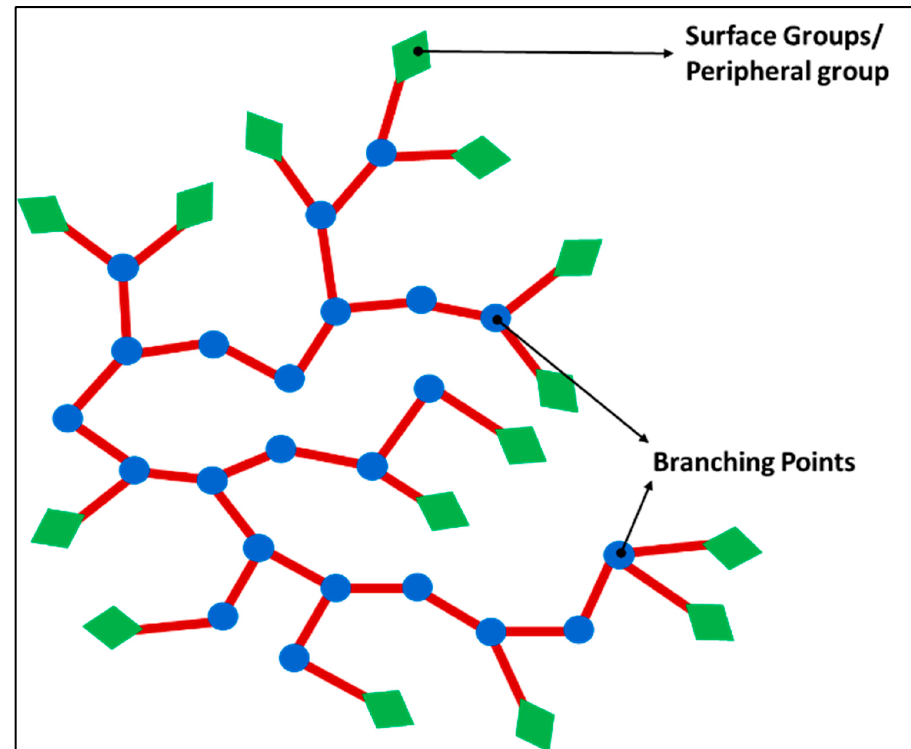
Figure 4. Hyperbranched polymers structure - the polymer structure is a randomly branched polymer with circles (blue) representing the branching points and rhombus shapes(green) for surface groups.